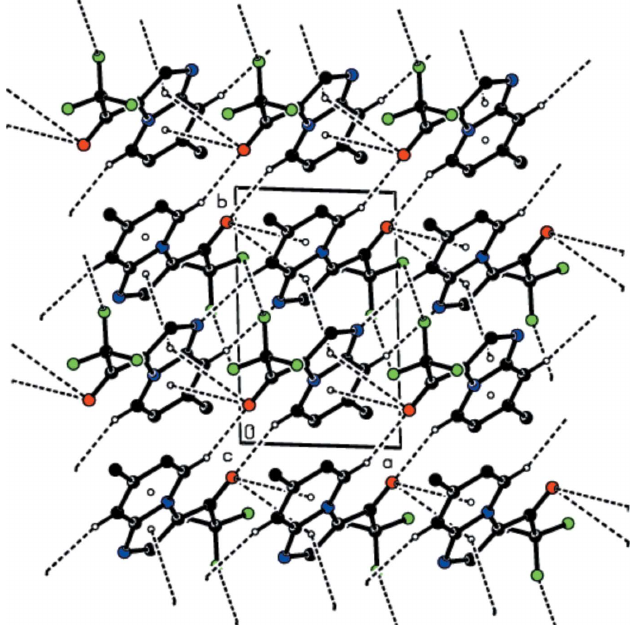
Figure 5 Packing diagram of the title compound, viewed down the c axis showing the C—H (cid:2)(cid:2)(cid:2) O and C—H (cid:2)(cid:2)(cid:2) N hydrogen bonds and the F (cid:2)(cid:2)(cid:2) F and (cid:2) – (cid:2) stacking interactions. Hydrogen atoms not involved in hydrogen bonding are omitted.